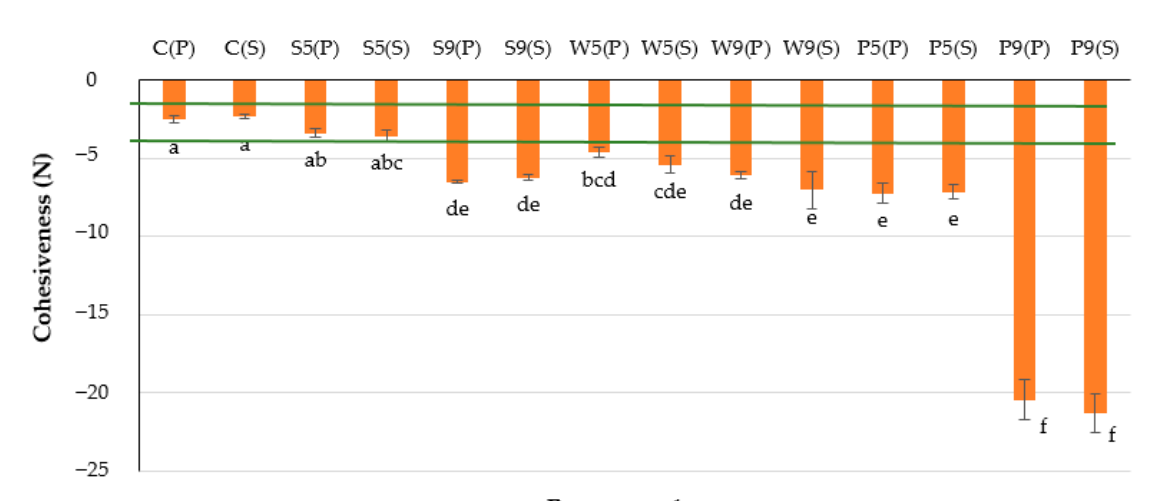
Figure 3. Cohesiveness of the plant-based purées. The initial letters in sample abbreviations, C—control (without protein additive), S—soy, W—whey or P—pea protein, represent the samples used in the formulations; the numbers represent the proportions of protein added (5 or 9 g/100 g); the letters in brackets represent the type of secondary treatment (P—pasteurization; S—sterilization). Horizontal lines indicate the target values. Different letters indicate significant differences between samples ( p ≤ 0.05).